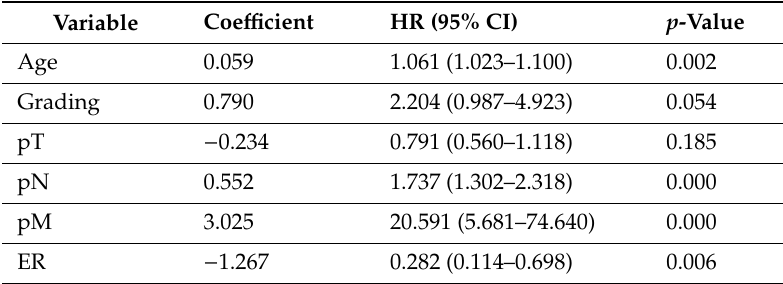
Table 2. Multivariate Cox regression analysis of unifocal patients regarding OS.